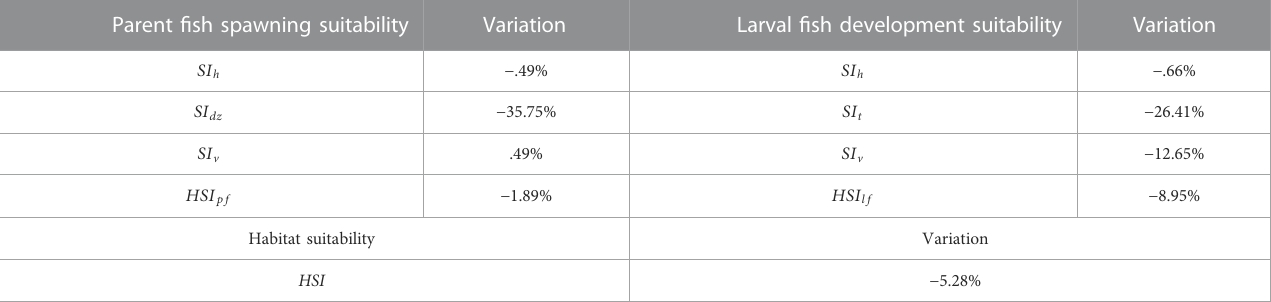
TABLE 4 Percentage variation of each suitability index ( SI ) for the Yellow River carp of the whole study area before and after the dam construction.